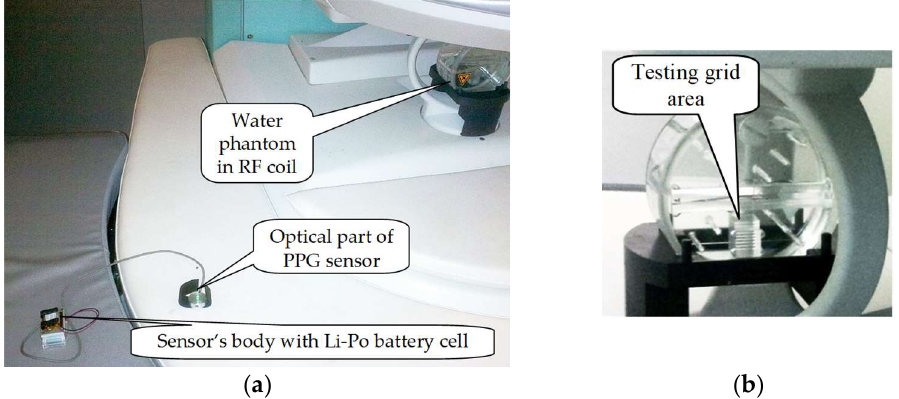
Figure 10. Arrangement of RSSI parameter measurement inside the MRI device E-Scan Opera: ( a ) overall photo with currently tested PPG-BLE sensor, ( b ) detail of used water phantom with a special testing grid area inside the RF receiving/transmitting coil.